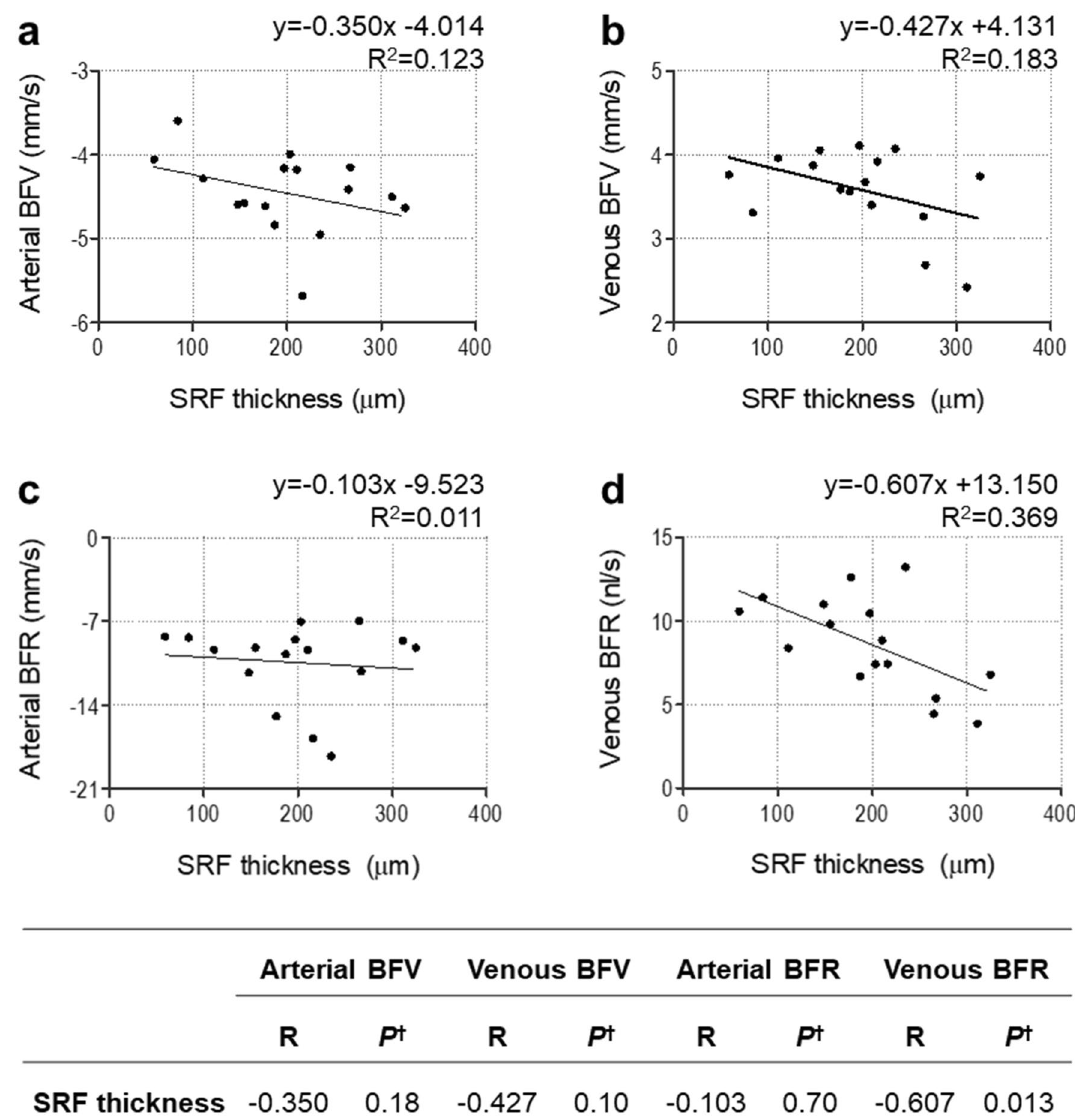
Figure 1. Relationship between subretinal fluid (SRF) thickness and arterial blood flow velocity (a) , venous blood flow velocity (b) , arterial blood flow rate (c) , and venous blood flow rate (d) in central serous chorioretinopathy. † Pearson’s correlation. BFR blood flow rate, BFV blood flow velocity, SRF subretinal